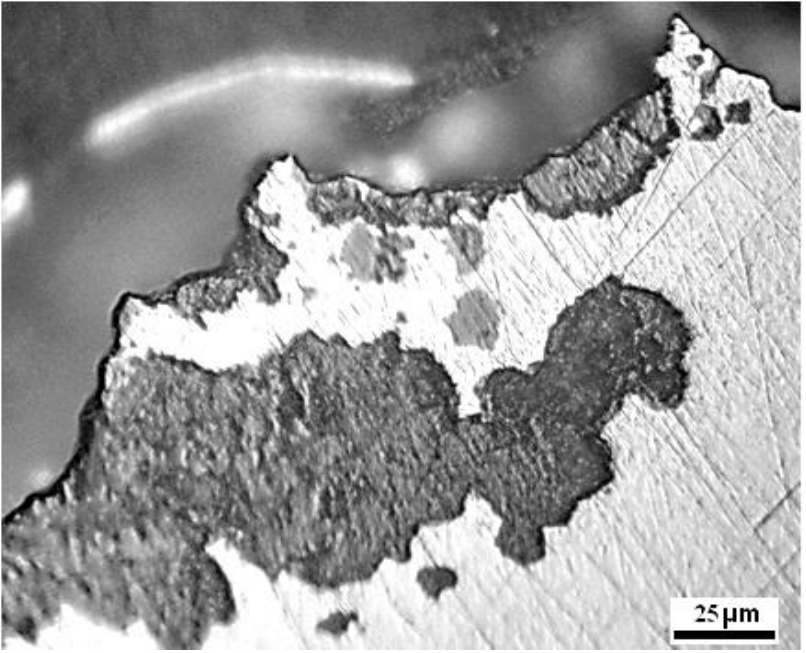
Figure 7. Cross section of corrosion pit from Figure 5.